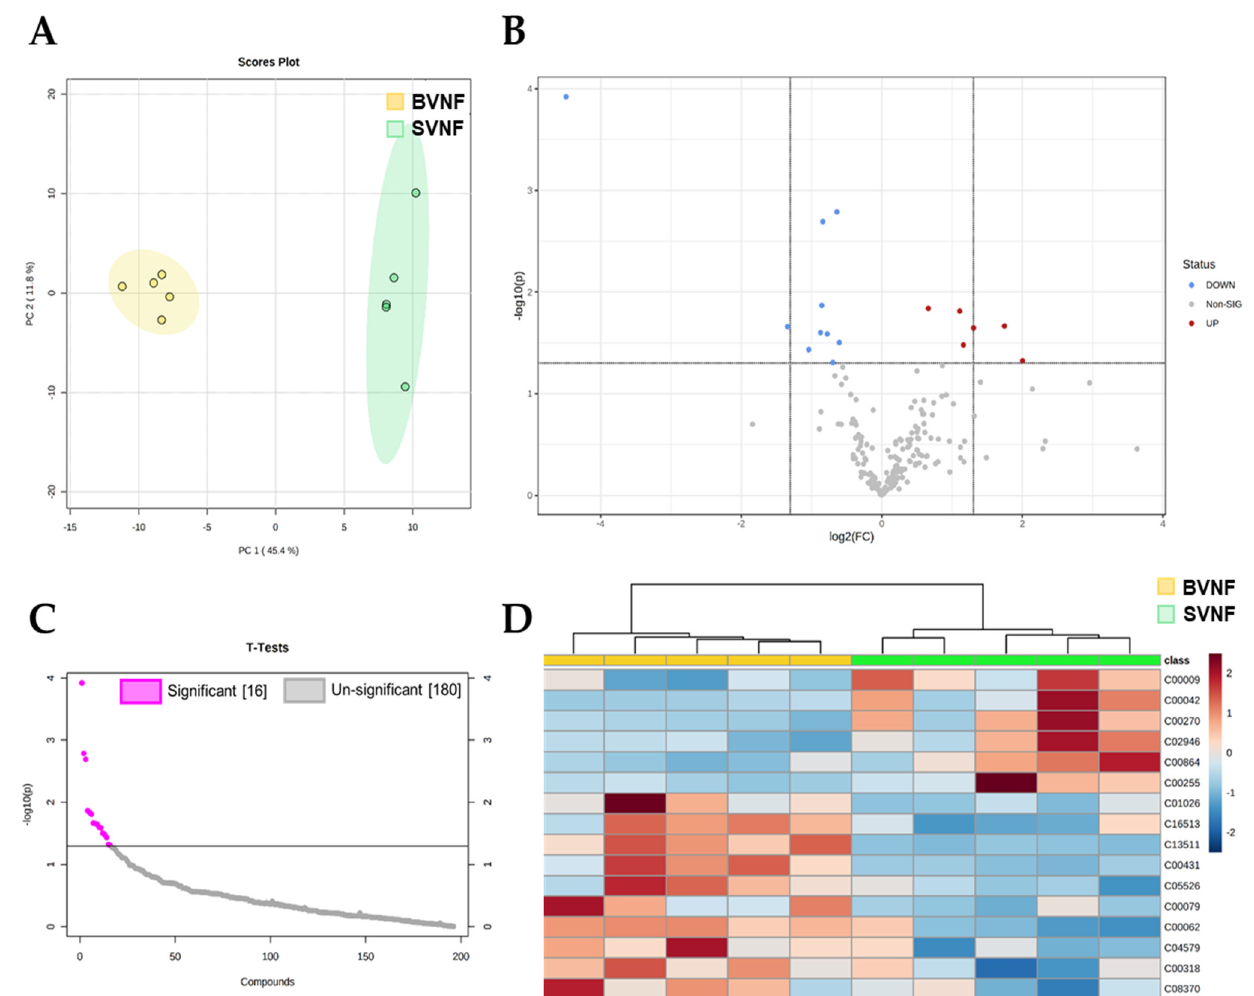
Figure 1. Serum metabolite profiling identified significant changes in non-failing SV subjects. ( A ) Principal component analysis of all identified metabolites segregated BVNF ( n = 5) and SVNF ( n = 5) serum samples. ( B ) Volcano plot representation of all the 196 metabolites detected by mass spectrometry as the log2 fold-change in expression ( x -axis) and the log odds of a gene being differentially expressed ( y -axis), highlighting the 16 metabolites that were significantly differentially expressed between BVNF and SVNF sera (above dotted line). ( C ) Significant and non-significant changes in serum metabolite expression in SVNF vs. BVNF. ( D ) Heatmap of the 16 significantly differentially expressed metabolites. Unsupervised hierarchical clustering separated BVNF ( n = 5) and SVNF ( n = 5) serum samples. Each sample is represented by a single column. The higher the intensity of the red color, the higher the abundance of the metabolite.